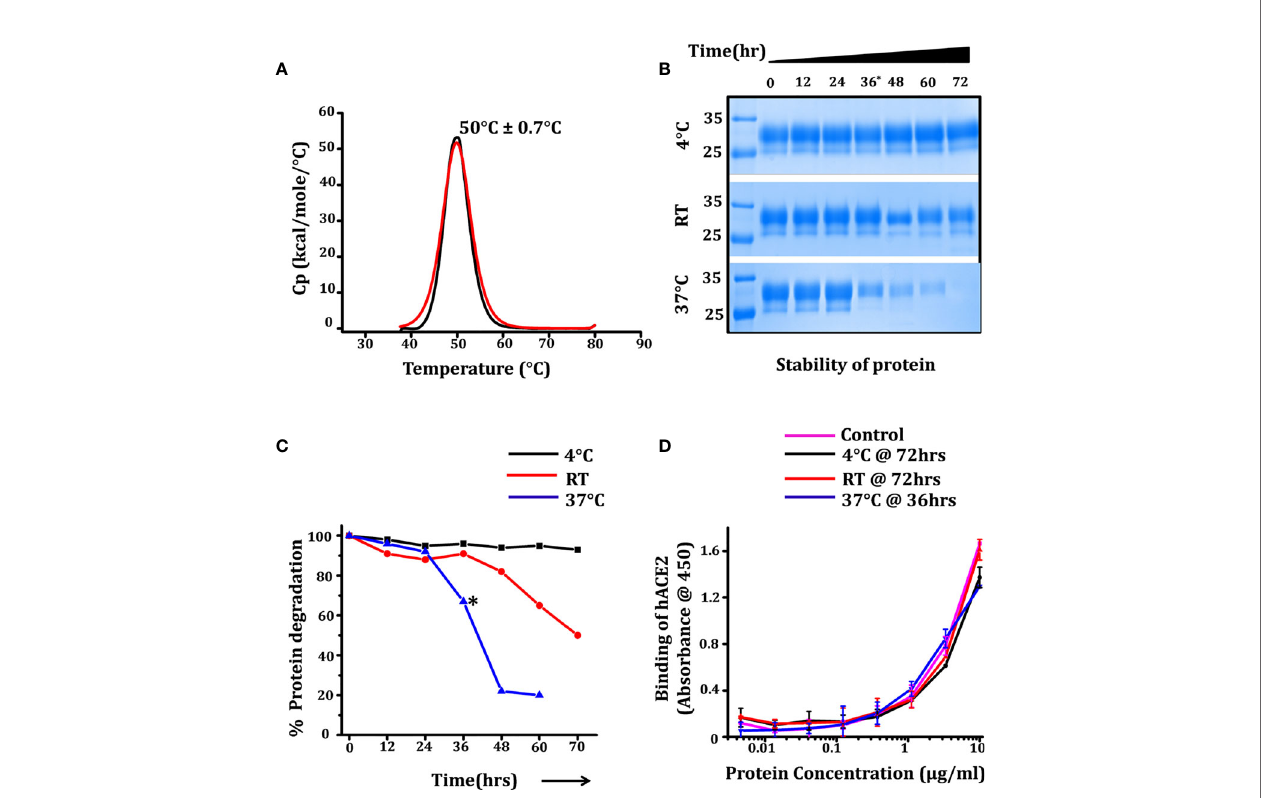
FIGURE 3 | Thermostability and prolonged survival of RBD over temperature range. (A) Differential scanning calorimetry (DSC) measuring the melting temperature ( T m ) of RBD, black and red graphs showing the thermogram and fi tted curve. (B) SDS protein gel showing the stability of protein for 72 h at three different temperatures, each aliquot was harvested at 12 h intervals. (C) Density intensity plot of RBD-incubated samples were analyzed using ChemiDoc MP (version 4.1) and plotted with reference to the samples intensity at 0 h. (D) ELISA graph showing the dose-dependent reactivity of end point incubated RBD (72 h for 4°C and RT incubation and 36 h for incubated samples at 37°C) with hACE2-Fc, the control graph represents the relative activity of RBD at the 0 h time point. Statistical signi fi cance was determined using the one-way ANOVA test (p < 0.05). Where *p < 0.05 (One-way